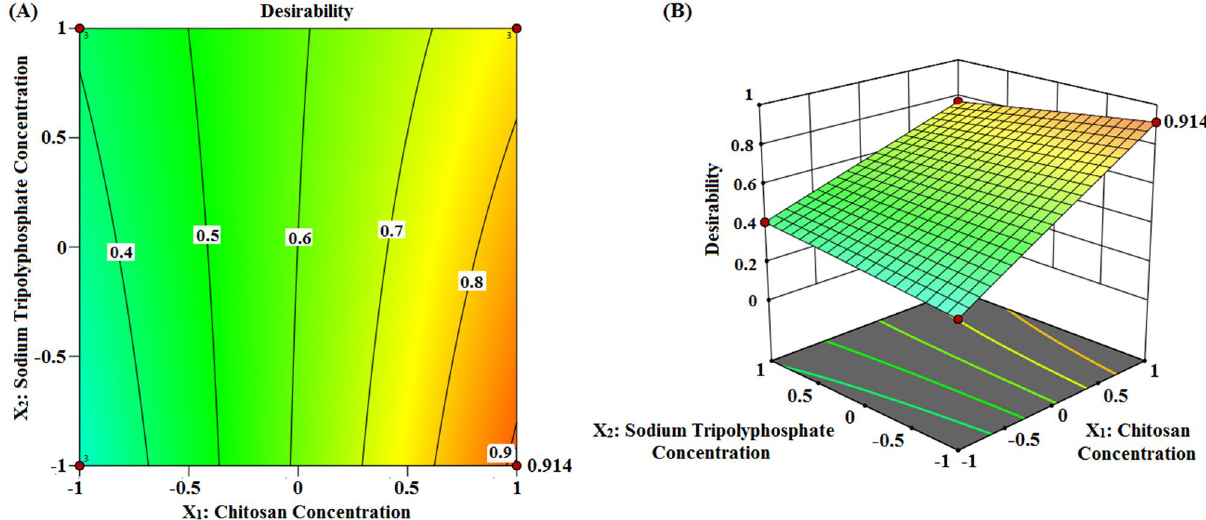
Figure 4. Optimization graph. ( A ) Contour and ( B ) three dimensional plots with desirability score using Design-Expert version 12 (/https ://www.state ase.com/softw are/desig n-exper